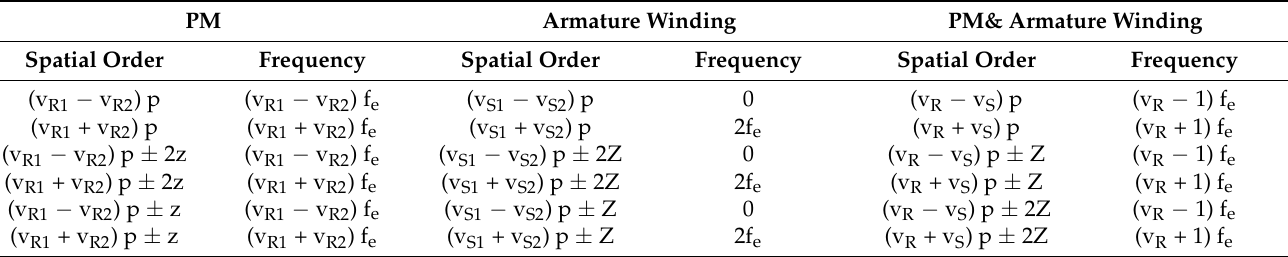
Table 2. Sources of radial electromagnetic